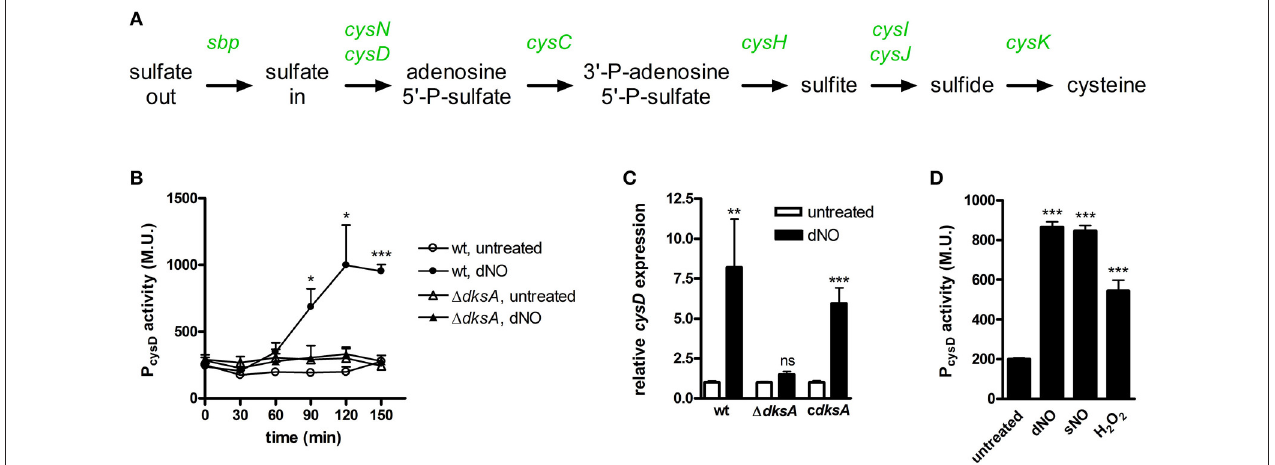
FIGURE 4 | DksA-dependent transcriptional activation of sulfur assimilation and cysteine biosynthesis in response to nitrosative and oxidative stress. (A) • NO- and DksA-dependent transcriptional up-regulation of genes encoding sulfur assimilation and cysteine biosynthetic pathways are indicated in green text. (B) cysD promoter activity in untreated and 5 mM dNO-treated Salmonella . Data are expressed as Miller Units (M.U.) and are the mean ± SEM, n = 3; * p < 0.05 and *** p < 0.001 compared to untreated wild-type Salmonella . (C) cysD expression in wild-type (wt), 1 dksA , and dksA -null Salmonella complemented with the native dksA allele (c dksA ) following treatment ± 5mM dNO for 30 min as measured by qPCR. Gene expression, normalized to the house-keeping gene gene rpoD , is expressed as fold change relative to untreated controls. Data are the mean ± SEM, n = 3; ** p < 0.01, and ns (non-significant) compared to the respective untreated control. (D)